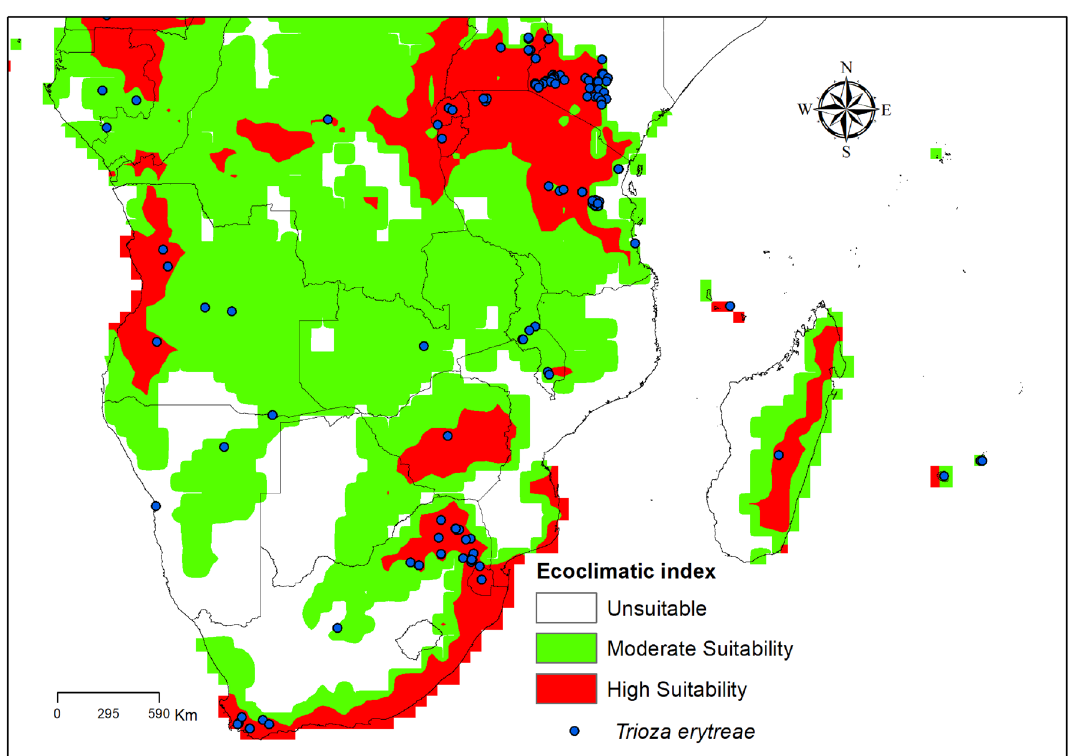
Figure 2. Detail of Known Trioza erytreae on the Ecoclimatic index (EI) map from CLIMEX prediction. ESRI ArcMap 10.2.2 (https:// suppo rt. esri. com/ en/ Produ cts/ Deskt op/ arcgis- deskt op/ arcmap/ 10-2- 2# downl oads) and CLIMEX 4.0.0 (https:// www. hearne. softw are/ Softw are/ CLIMEX- DYMEX/ Editi ons).